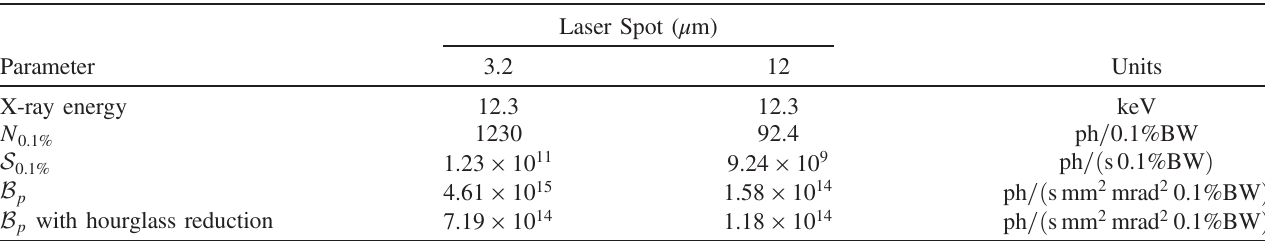
TABLE XV. X-ray performance of the designs attained by numerical simulation with an aperture of 1 = 40 γ . Suggested aperture for brilliance calculation only.